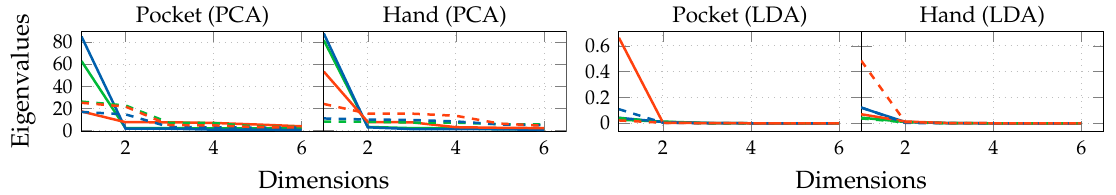
Figure 10. Scree-Plots for a preliminary examination of the information redundancy using both PCA and LDA within a window of length 2s for pocket-case and hand-case. Green, red, and blue lines represent x, y, and z axes of the accelerometer (solid) and gyroscope (dashed)